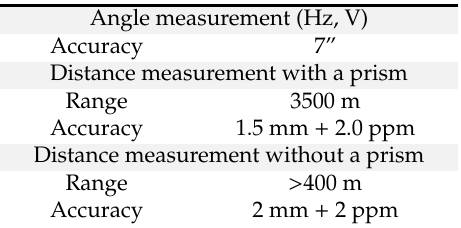
Figure 6. Leica TS 02 total station. Table 1. Leica TS02 characteristics.